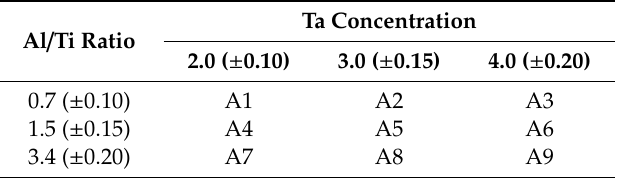
Table 3. Nominal composition of Inconel 740, Inconel 740H and limits, according to ASTM requirements, with the nominal values in our modified variants